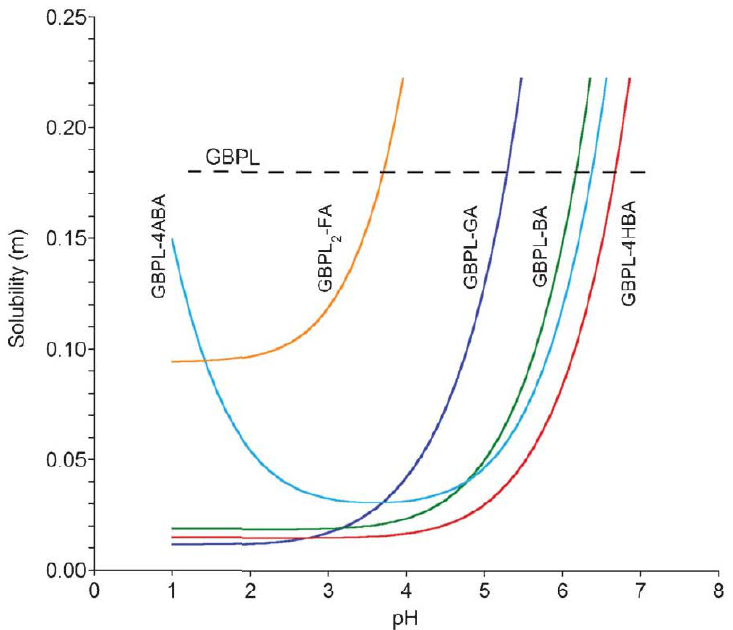
Figure 35. Solubility-pH profiles of Gabapentin-lactam-4-aminobenzoic acid (GBPL-4ABA), Gabapentin-lactam-fumaric acid (GBPL 2 -FA), Gabapentin-lactam-gentisic acid (GBPL-GA), Gabapentin-lactam-benzoic acid (GBPL-BA) and Gabapentin-lactam-4-hydroxybenzoic acid (GBPL-4HBA) cocrystals with respect to raw Gabapentin-lactam (GBPL) cocrystal [Reprinted from [316] with permission. Copyright 2016 Royal Society of Chemistry].